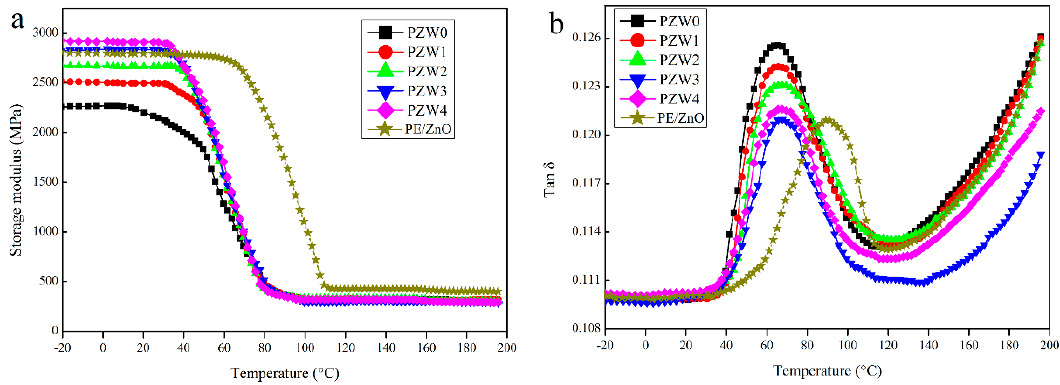
Figure 8. The storage modulus ( a ) and tan δ ( b ) curves of the PE/ZnO composite and the PZW composite, with different contents of ZnO NPs.